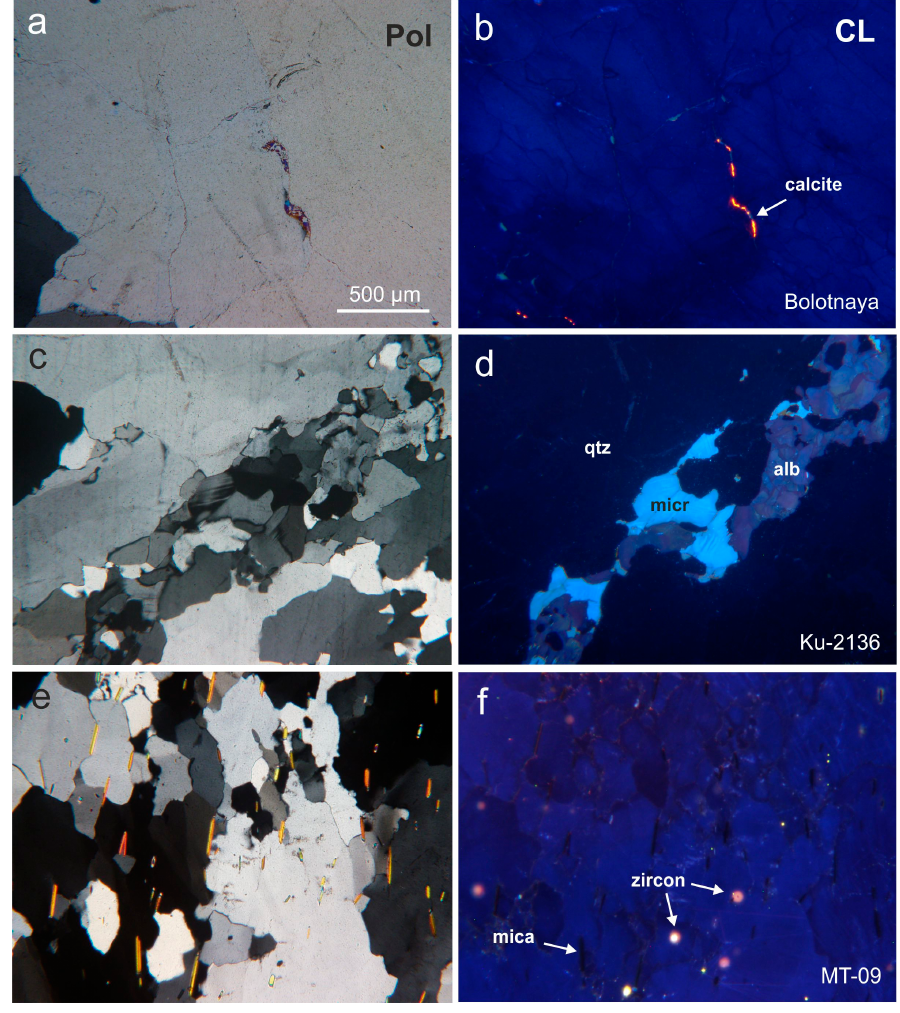
Figure 2. Micrograph pairs in transmitted light (crossed polars—Pol) and cathodoluminescence (CL) showing micro-inclusions of minerals in the quartz samples: ( a , b ) calcite in the hydrothermal quartz from Bolotnaya (Bolot); ( c , d ) microcline (micr) and albite (alb) in metamorphically overprinted hydrothermal quartz from Kuznechikhinsk (Ku-2136; ( e , f ) mica (non-luminescent) and zircon with radiation haloes in the quartzite from the Taganai ridge (MT-09).